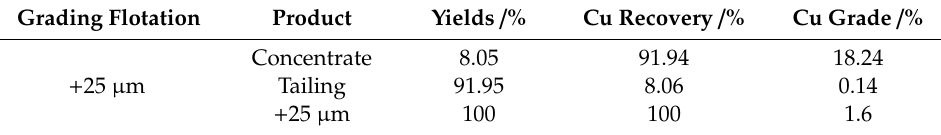
Table 4. Flotation grade and recovery of +25 µm malachite.